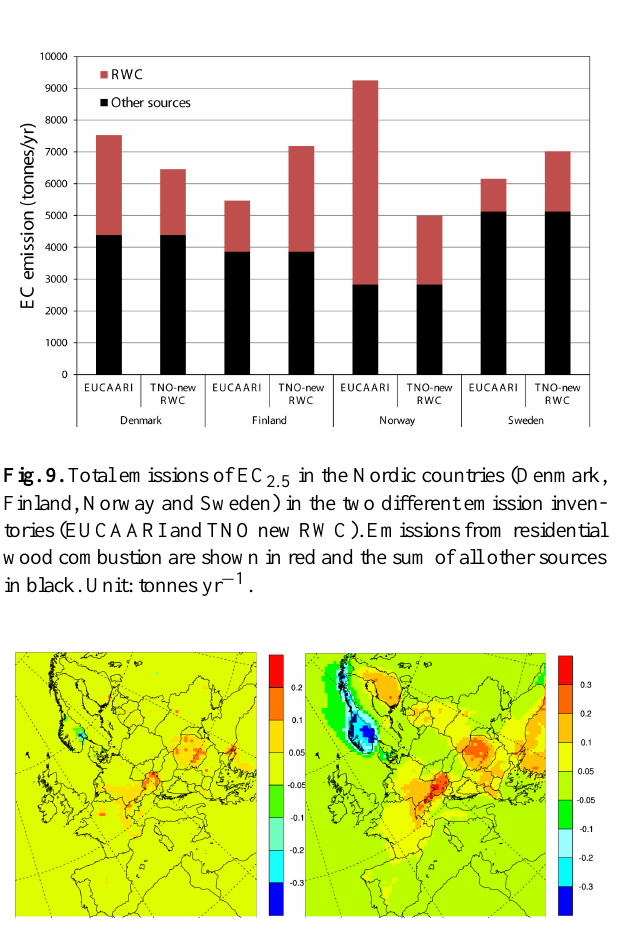
Fig. 10. Difference in modelled total EC 10 concentrations (six-year mean, 2005-2010) between a model run using the new residential wood combustion emission inventory (TNO new RWC) and a run using the EUCAARI emission inventory. Left: The difference in total EC 10 [TNO new RWC - EUCAARI] (unit: µg m -3 ). Right: The relative difference in total EC 10 [(TNO new RWC- EUCAARI) / (EUCAARI)].